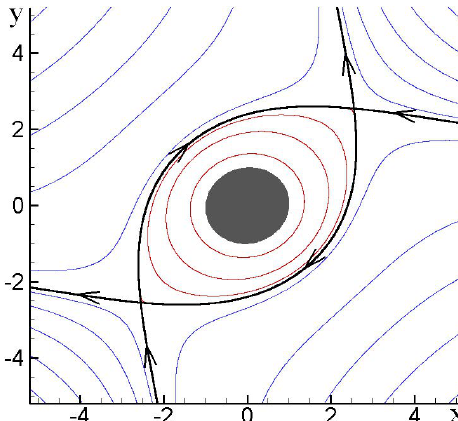
Fig. 1. A phase portrait of stationary system (5) as e = 0 . 1, γ = 0, a( 0 ) = 1 . 0551, θ ( 0 ) = π . The bold black curve is the separatrix b( 0 ) 4 dividing the closed recirculation zone (red lines) with the vortex (the grey region), and the hyperbolic exterior flow region (blue lines).